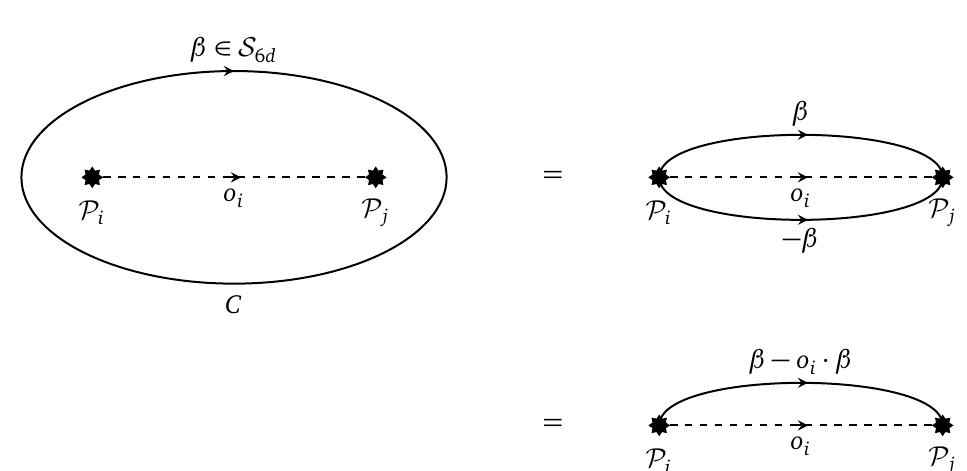
Figure 23: Topological move showing that a 4 d line defect obtained by wrapping the surface defect β ∈ S alent to a 4 d line defect obtained by wrapping β − o from the puncture P automorphism twist